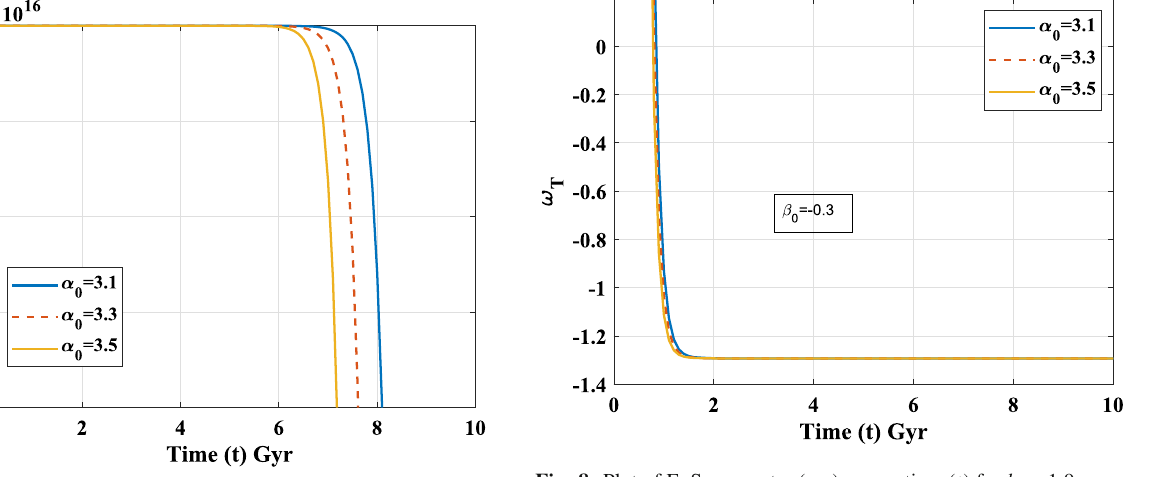
Fig. 6 Plot of v 2 s versus time ( t ) for k = 1 . 9, α 1 = 1 . 2, α 2 = 0 . 52, and γ 1 = 101